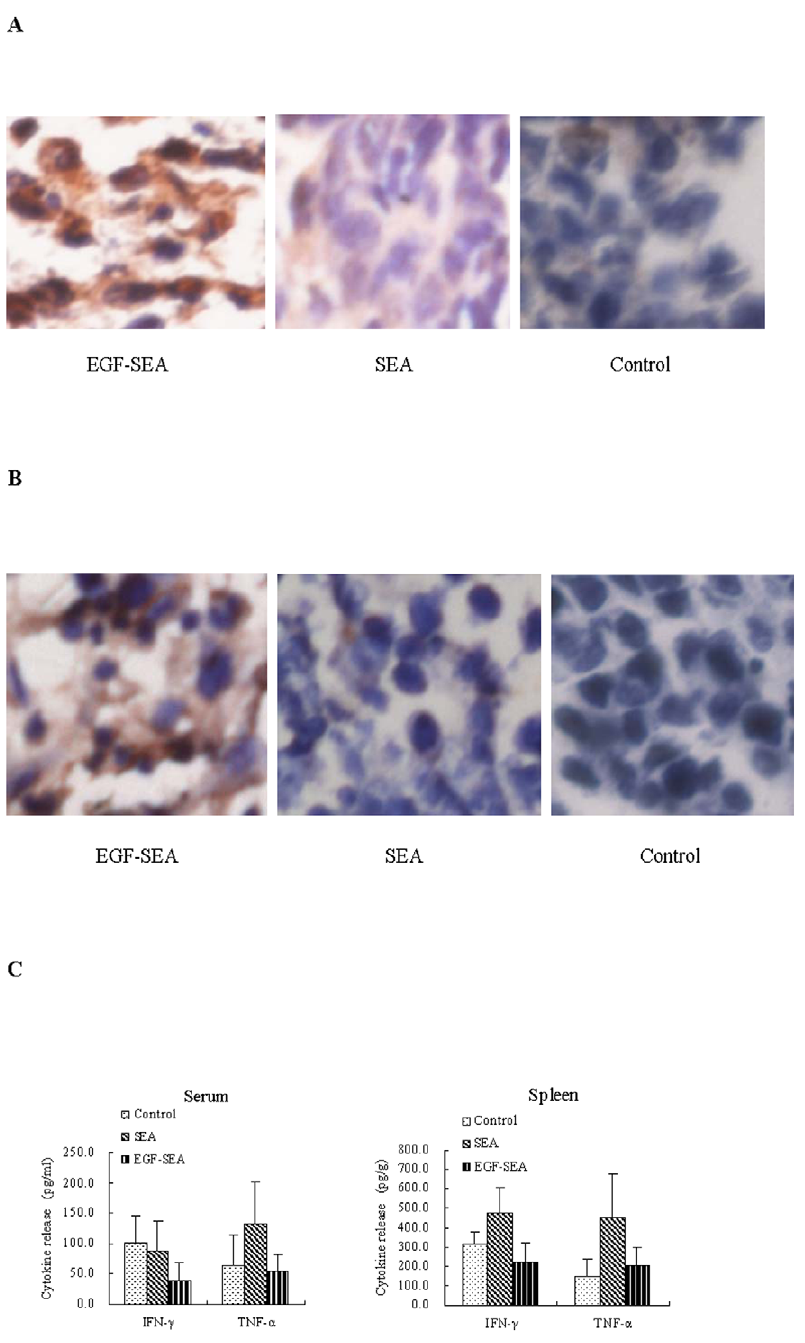
Figure 4. Cytokine release in mice bearing S180 tumors. (A) TNF- a secretion in tumors. The sections were labeled with rabbit TNF- a -specific polyclonal antibody. (B) IFN- c secretion in tumors. The sections were labeled with rabbit IFN- c -specific polyclonal antibody. (C) Cytokine secretion in mice. The data represented cytokine levels in sera in pg/ml and in spleens in pg/g. Cytokines in blood and spleen samples were measured using specific ELISA kits. Microscope magnification: 6 400 in A and B.